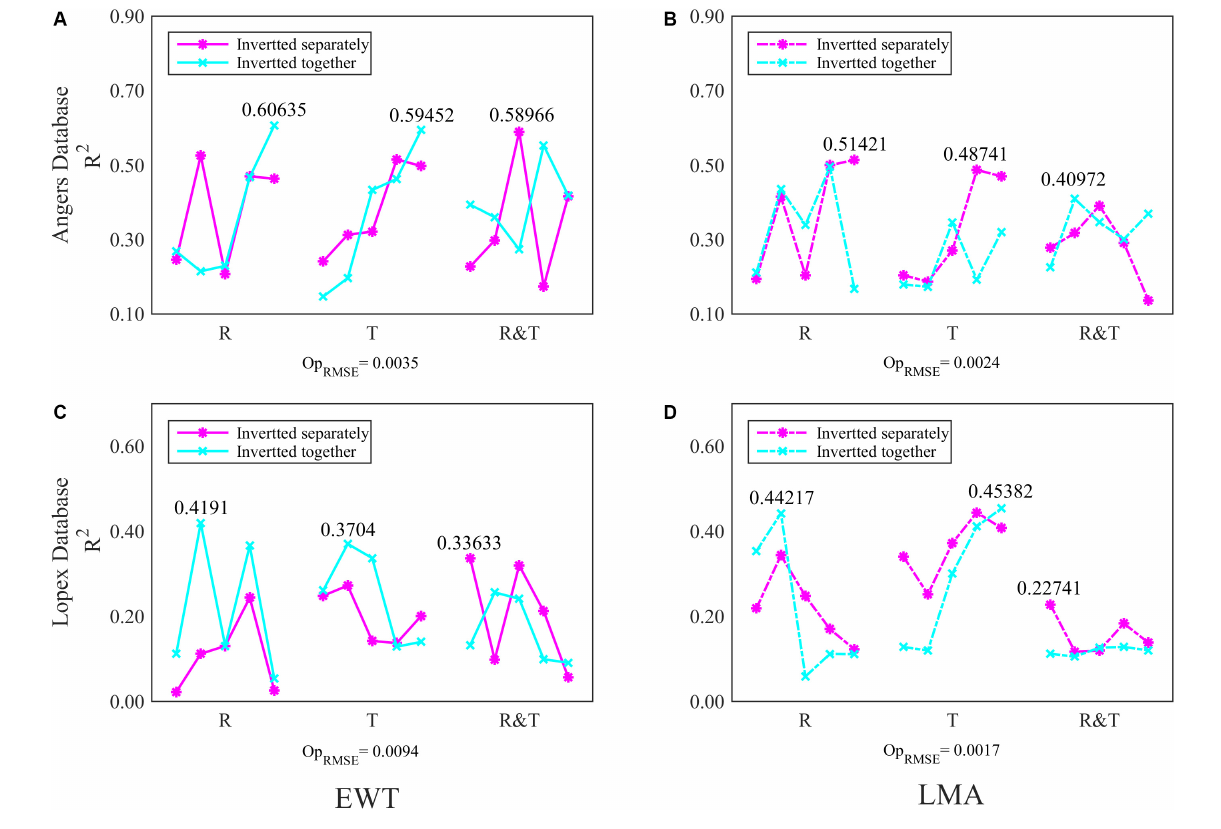
FIGURE 6 | The R 2 of FW-ANN models for (A) , (B) EWT and (C) , (D) LMA analysis in two databases. The first 20, 50, 100, 200, and 500 (five scatters in each spectral group) spectral bands of R, T, and R&T were chosen for analysis models respectively. The optimal train function is